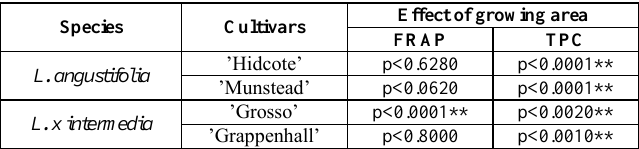
Table 3. Evaluation of the effect of growing area on the antioxidant capacity (FRAP) and total polyphenol content (TPC) of cultivars involved.